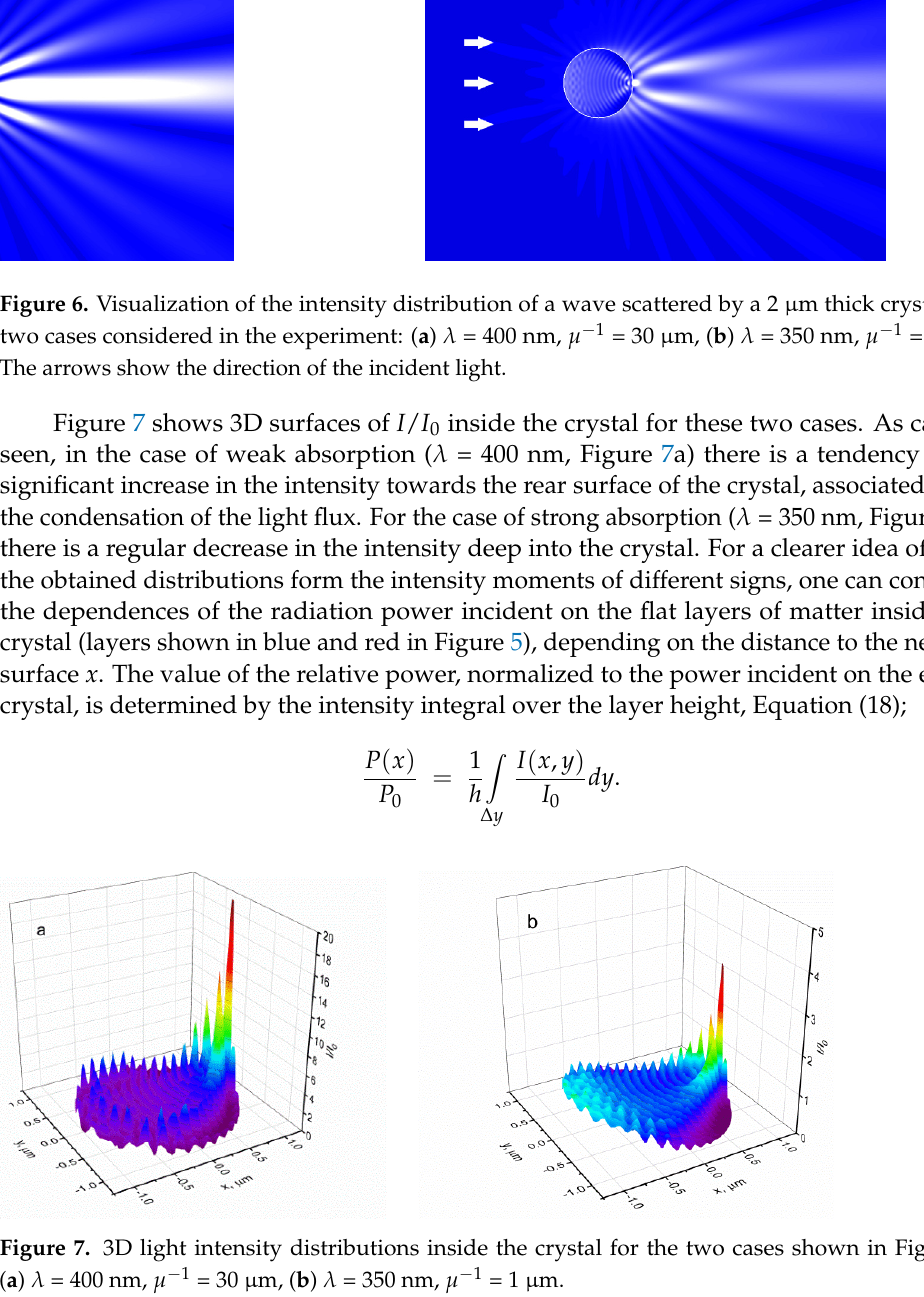
Figure 8. Relative power of radiation incident on vertical sections of a crystal at different depths. Figure 9 shows the results of calculations of the reduced moment of intensity Ω r